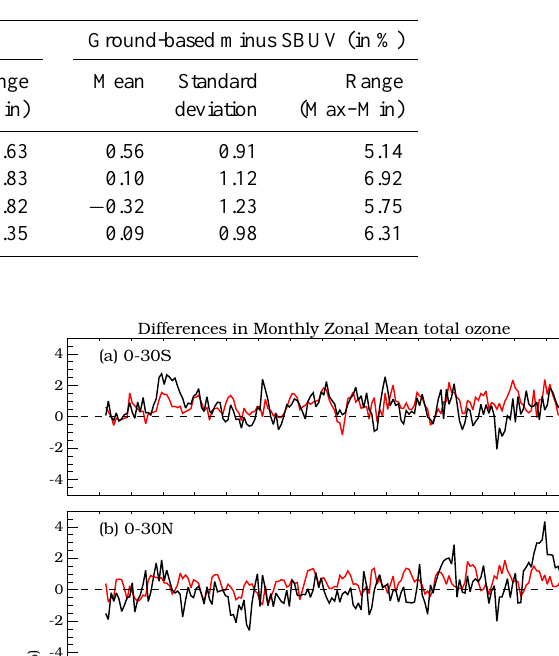
Table 4. Summary of the differences in monthly zonal mean total ozone (four broad latitudinal zones).